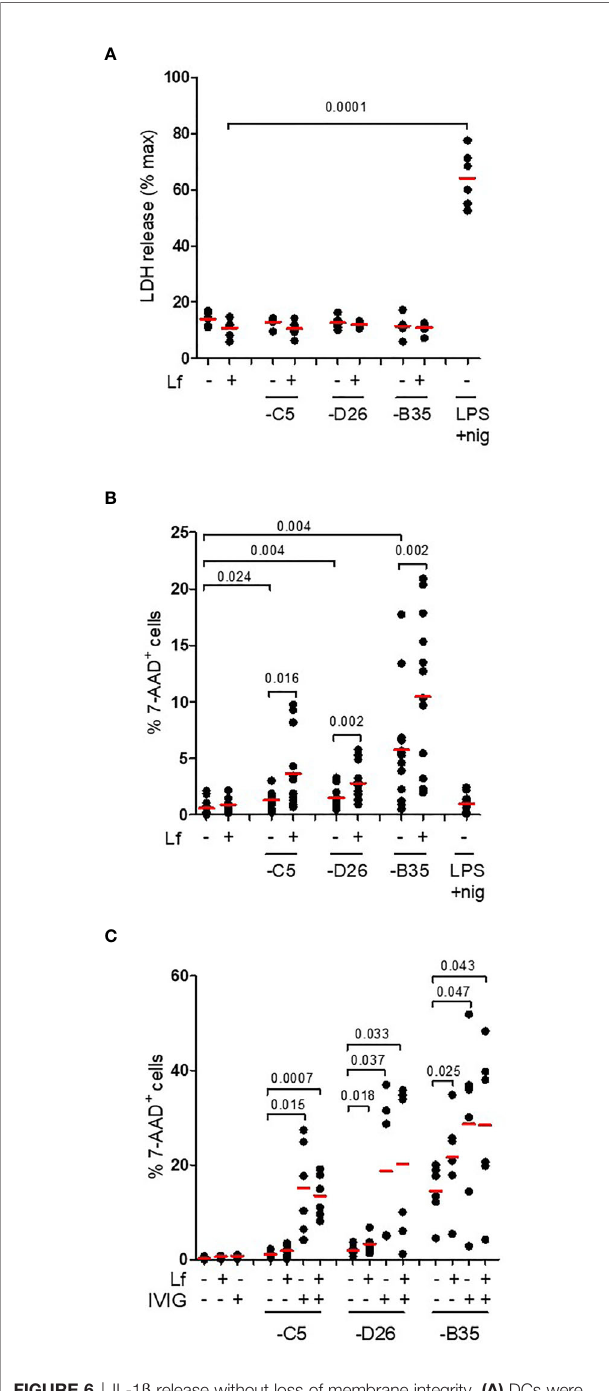
FIGURE 6 | IL-1 b release without loss of membrane integrity. (A) DCs were challenged with HAdV-lactoferrin complexes, HAdV alone, or LPS/nigericin. Loss of cytosolic content was quanti fi ed by LDH activity in the supernatant at 4 h post-incubation (n = 6); (B) Plasma membrane integrity, analysed 24 h post-incubation using 7-AAD uptake, was quanti fi ed using fl ow cytometry (n = 13); (C) DCs were incubated with HAdV complexed with lactoferrin, IVIG or lactoferrin + IVIG. Plasma membrane integrity was analysed by 7-AAD uptake by fl ow cytometry at 24 h post-incubation (n ≥ 3). Statistical analyses by two-tailed paired